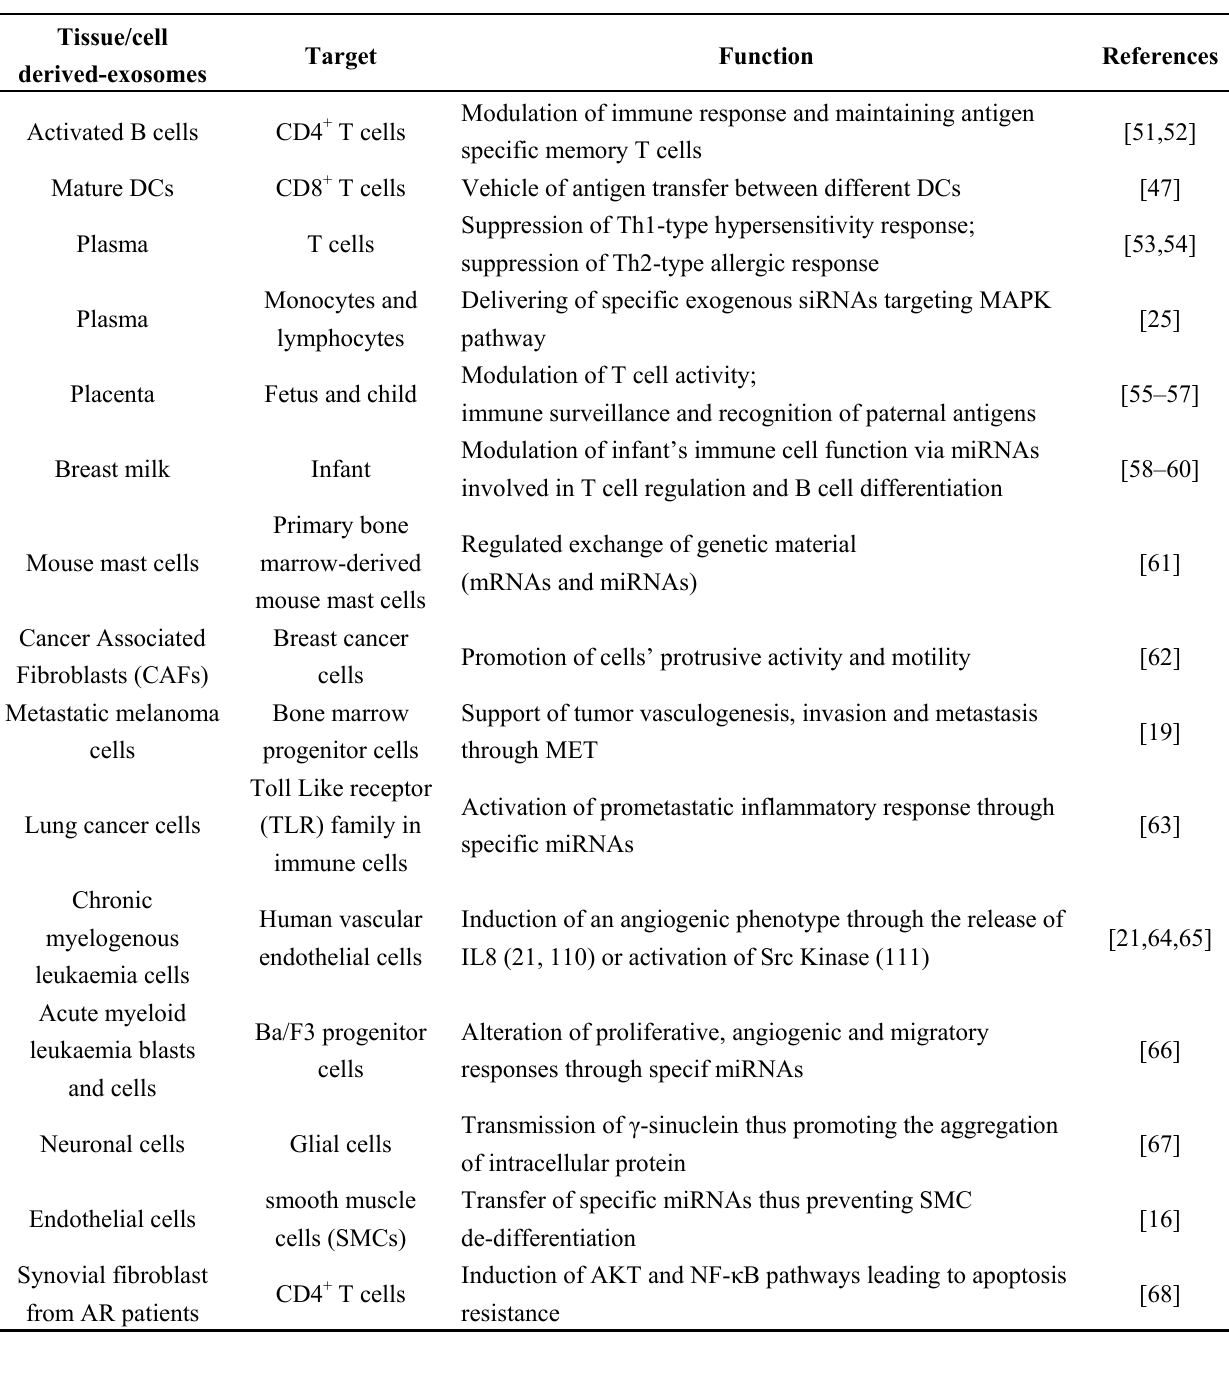
Table 1. Functions of tissue derived-exosomes in physiology and